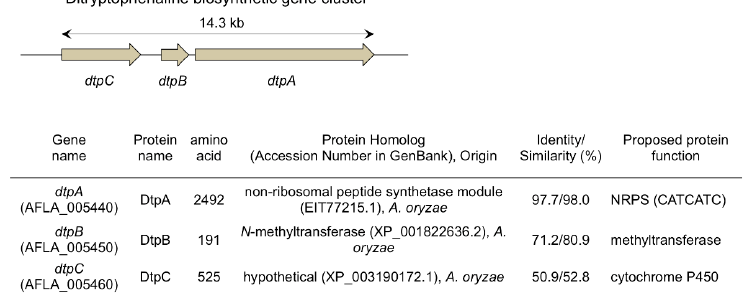
Figure 3. Aspergillus flavus ditryptophenaline biosynthetic gene cluster and predicted functions of the genes in the cluster.